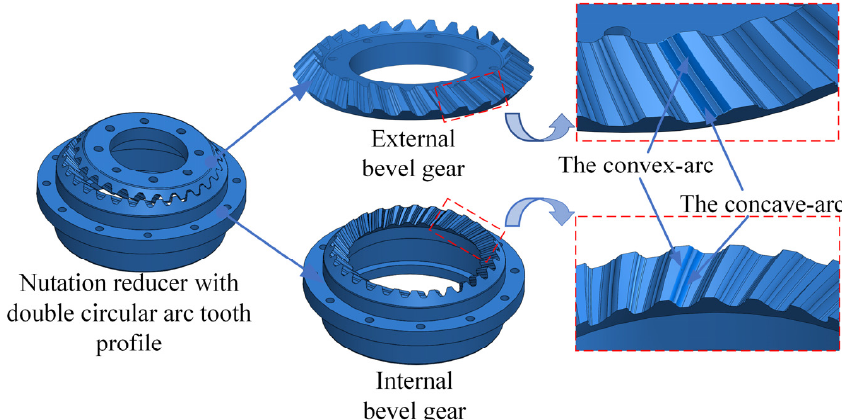
Figure 1. Double-arc spiral bevel gear nutation reducer.